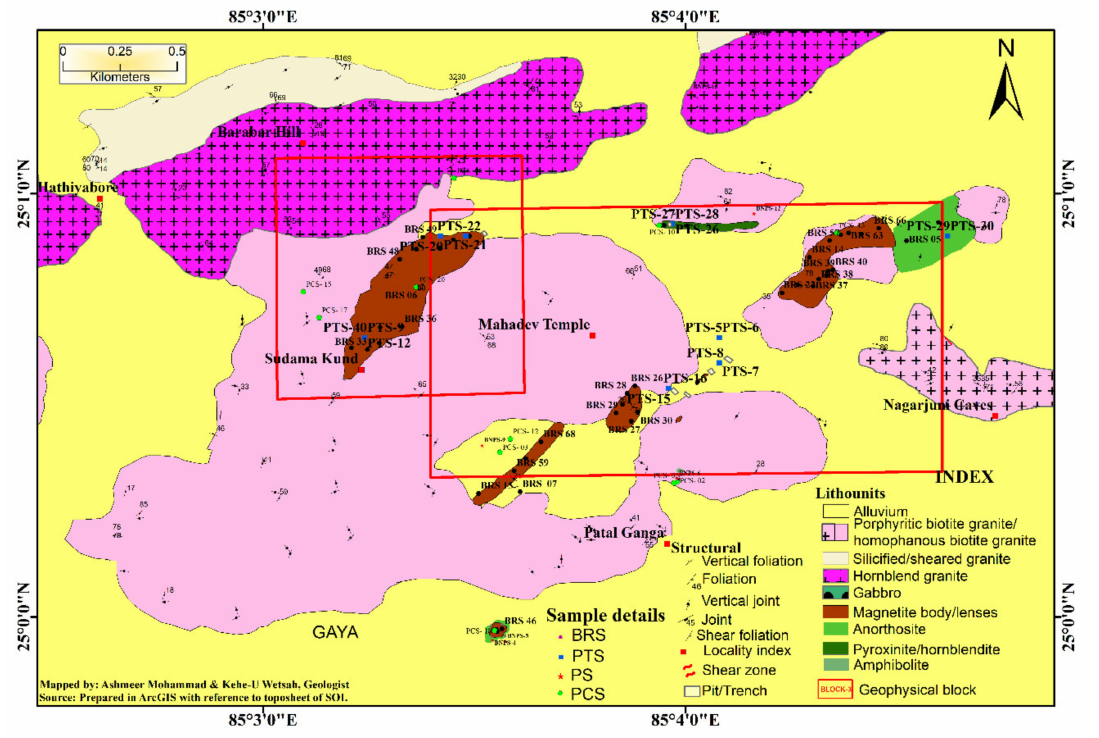
Figure 3. Geological map of Sudamakund area, in parts of Gaya and Jehanabad districts, Bihar.